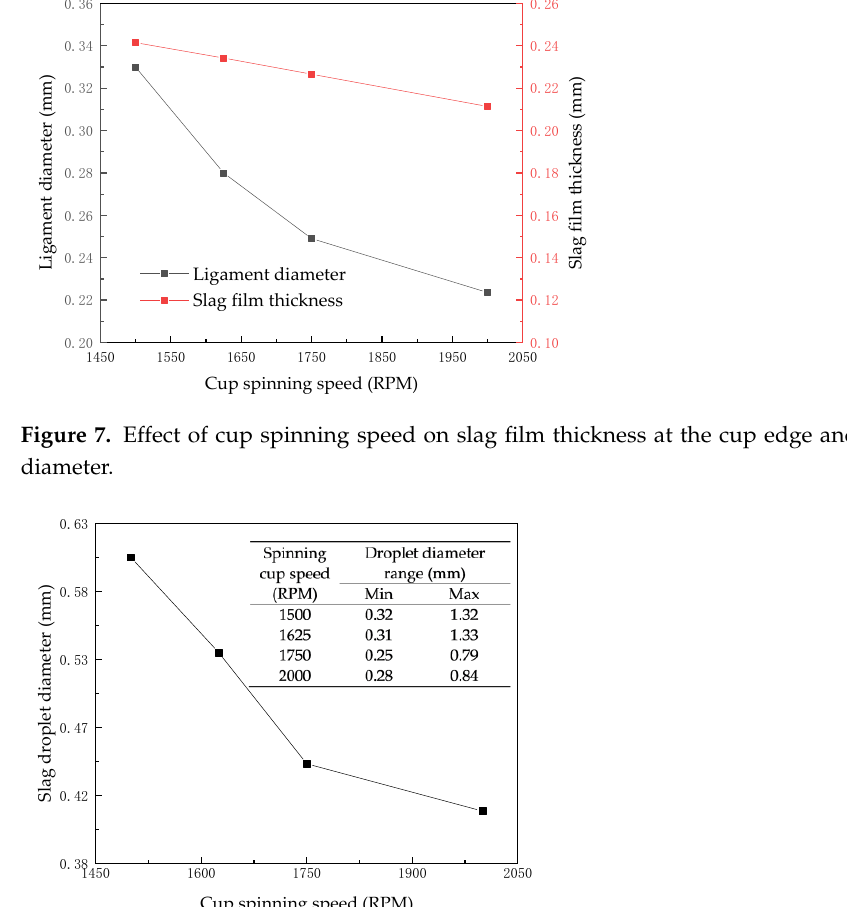
Figure 6. CFD simulation results on centrifugal granulation of molten slag at a flowrate of 3 kg min −1 and different cup spinning speeds. ( a ): Cup spinning speed = 1500 RPM; ( b ): Cup spinning speed = 1625 RPM; ( c ): Cup spinning speed = 1750 RPM; ( d ): Cup spinning speed = 2000 RPM.